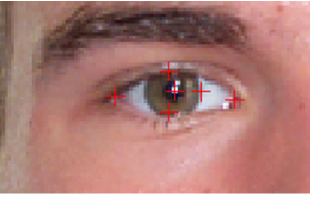
Figure 16. Eye landmarks used on the annotation of University of Michigan Face Database.